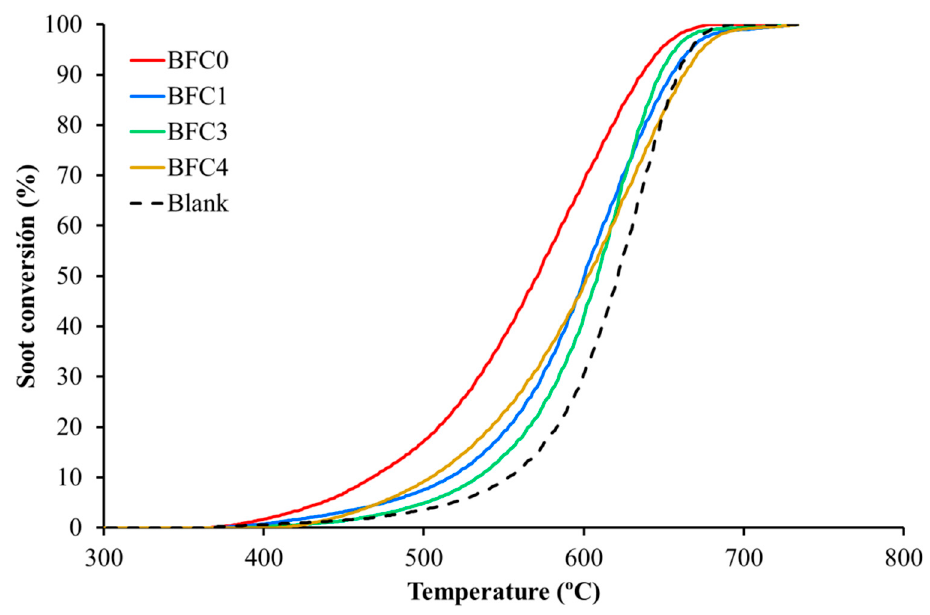
Figure 10. TPR soot conversion profiles in NOx for BaFe 1 − x Cu x O 3 catalysts. Table 4. Data for NO 2 -assisted diesel soot oxidation in TPR conditions BaFe 1 − x Cu x O 3 catalysts. Catalysts